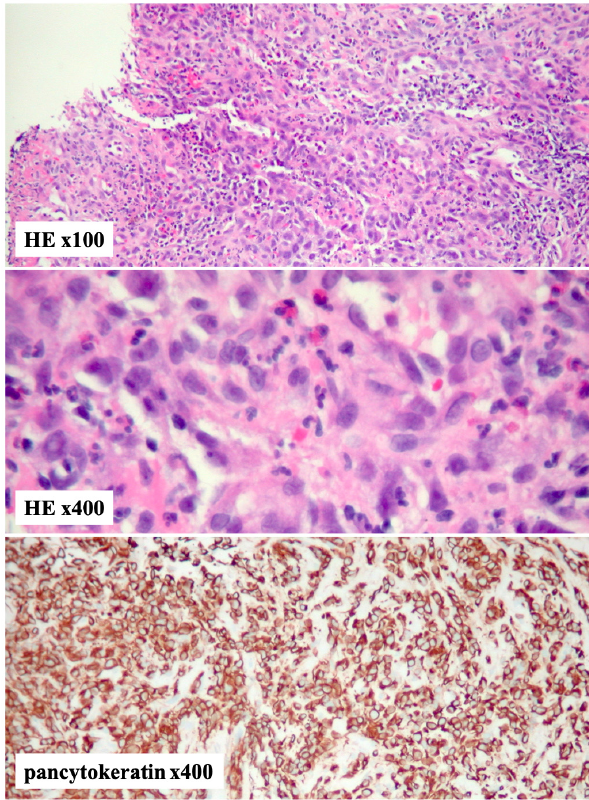
Figure 3. Pathology demonstrates an invasive poorly differentiated adenocarcinoma.